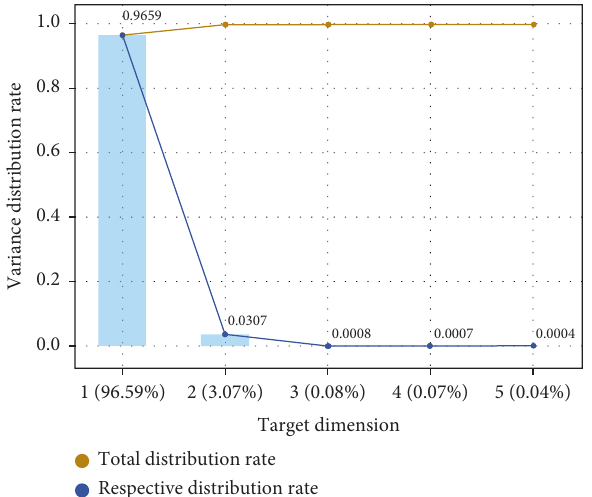
Figure 1: Take A-type stellar spectra as an example. The respective variance contribution rate of the first five of principal components when PCA is used in 6,000 spectra from SDSS. The value of the brown point represents the total variance distribution rate and the blue point represents the variance distribution rate of the specific principal